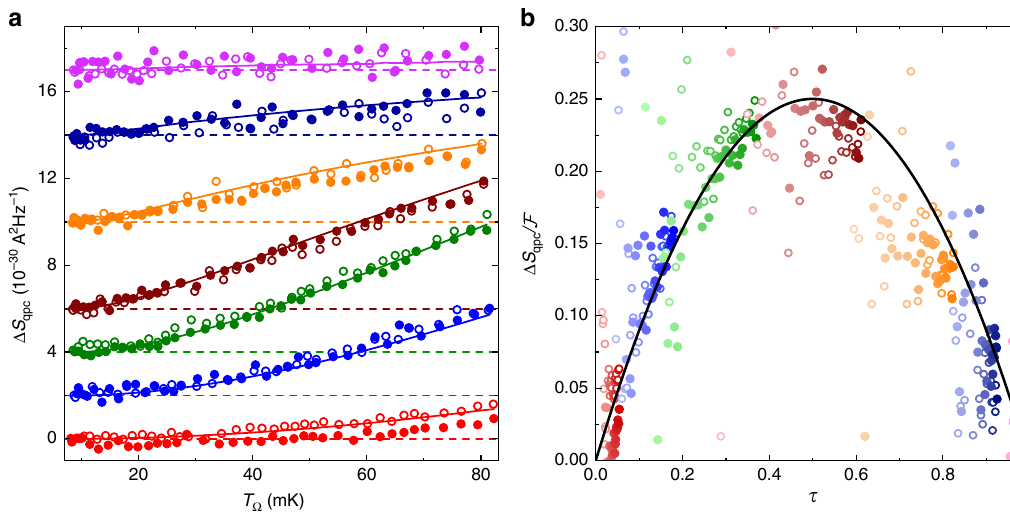
Fig. 2 Thermal shot noise. a Symbols represent the experimental QPC noise at N ¼ 2 from which the average thermal noise was removed (cid:1) T τ = R S ( Δ S 4 k , with (cid:1) T ¼ ð T Ω þ T Þ = 2). Measurements at different gate voltage tunings of the QPC are shifted vertically, with the applied offsets qpc ¼ qpc (cid:3) B K shown as horizontal dashed lines. Open and full symbols distinguish separate sequences of measurements. Continuous lines display Eq. (1) predictions. b The τ ð 1 (cid:3) τ Þ partition signature is shown as a continuous line versus τ . Symbols represent Δ S predicted thermal shot noise ’ s temperature dependence (see text). A lighter (darker) symbol coloring indicates a low (large) T Ω (cid:3) T corresponding to a higher (lower) experimental